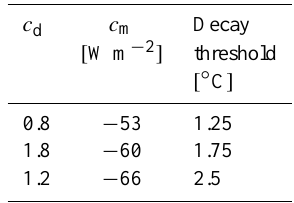
Table 1. Temperature threshold of the stability of the Greenland ice sheet for a number of valid model